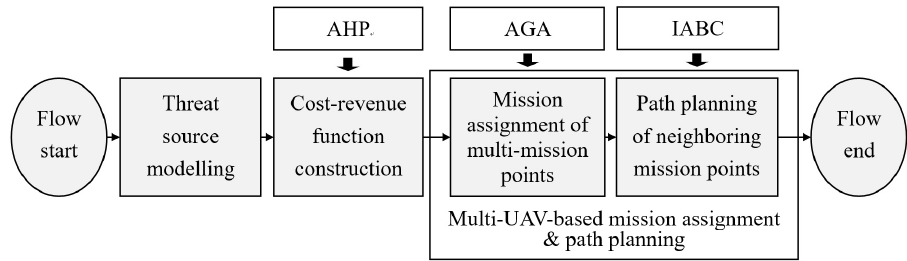
4 of 32 Figure 1. Sketch map of multi-UAV-based disaster rescue. 3. Optimization Modelling and Its Solution 3.1. The Proposed Computational Flow Chart Regarding the multi-UAV-based disaster rescue, two questions should be an- swered. The first question is how to plan the optimal mission allocation. That means the quantity and combination mode of multiple UAVs should be designed for a rescue task. The second question is how to plan their optimal flight paths between two neighboring mission points. Many factors, such as the threat sources and flight parameters will in- fluence the cruise path of UAV. To answer these questions, a novel method is proposed.